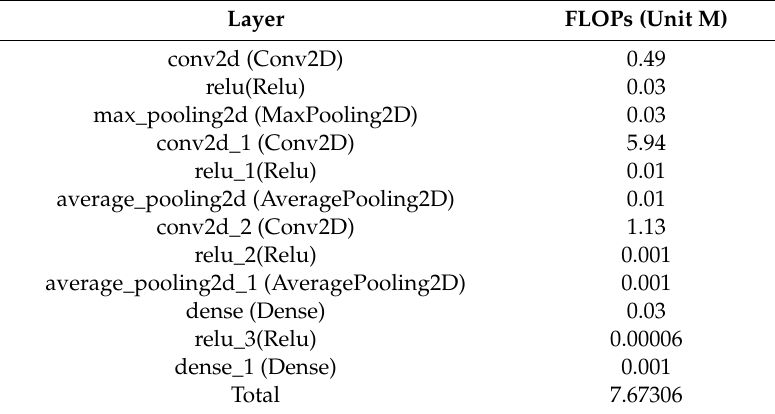
Table 2. Floating point operations (FLOPs) of each layer.